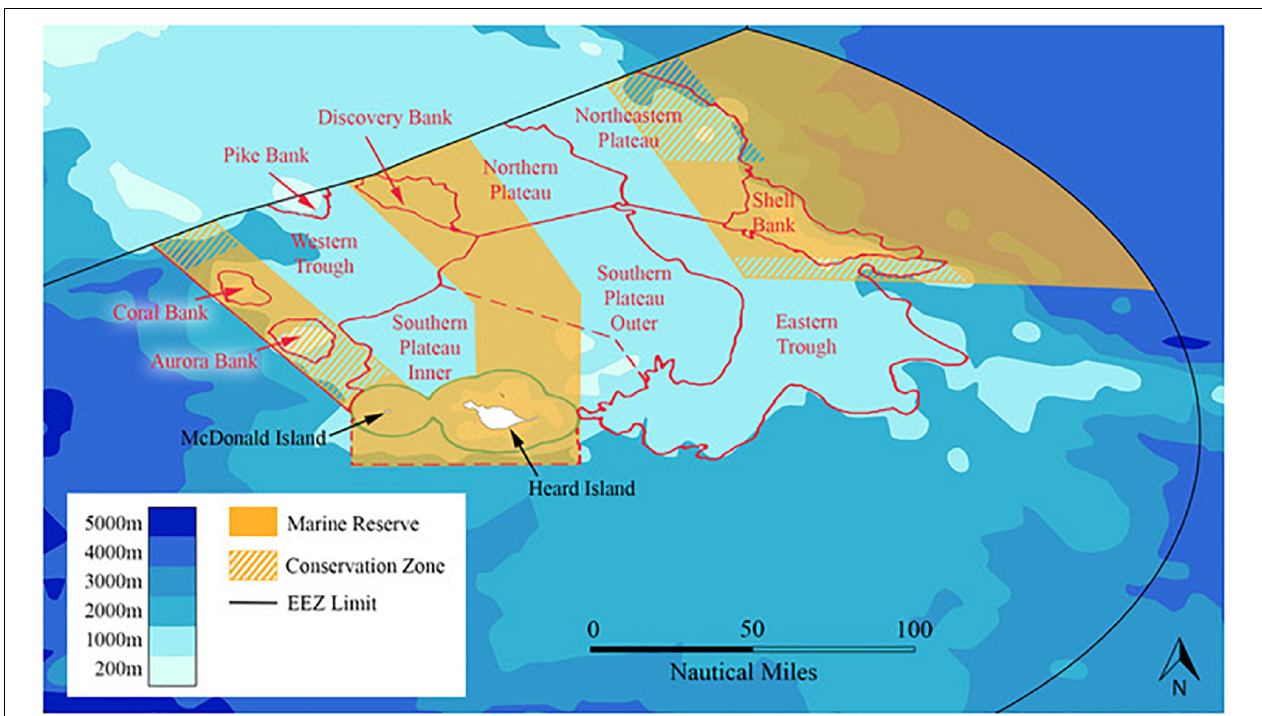
FIGURE 2 | Heard Island and McDonald Islands (HIMI) Marine Reserve and bioregions. Islands represented by white features. Bathymetry (1,000 m increments) is represented by blue coloration (with shallower areas being lighter in color). Red boundaries represent physical units underpinning the marine reserve proposal (based on Meyer et al., 2000). The 2002 HIMI Marine Reserve (65,000 km2) is shown in orange, with no-take areas represented by solid areas and Conservation Zones represented by the hatched areas. Conservation areas underwent further study before some of these regions were incorporated in an expanded HIMI Marine Reserve in 2014 (see text). The HIMI exclusive economic zone boundary is shown by the black